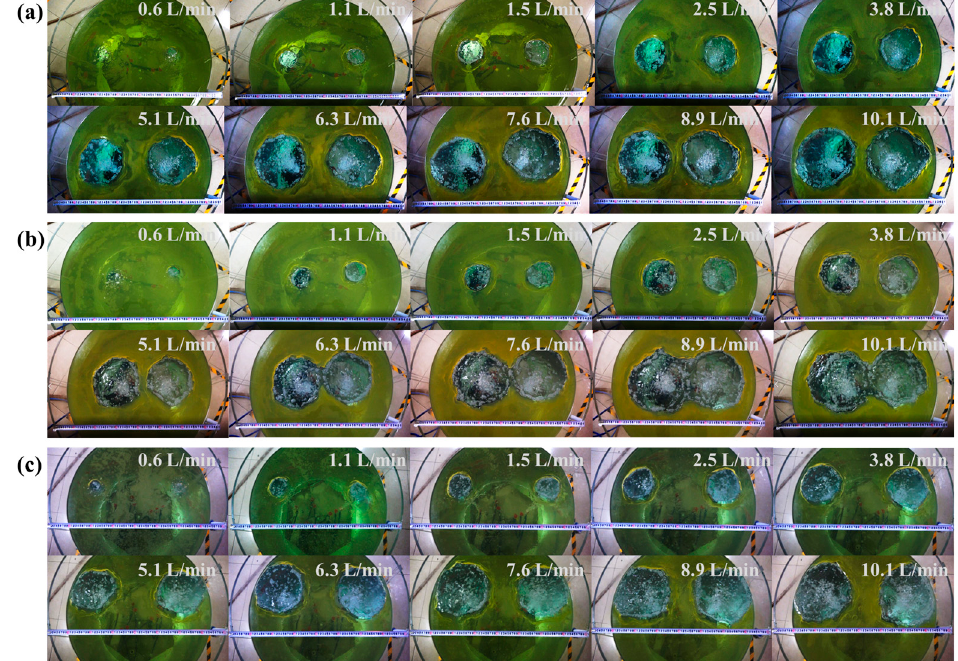
Figure 10. Slag surface exposure of double holes 2, 11 ( a ), 1, 11 ( b ) and 6, 12 ( c ) at different blowing rates.